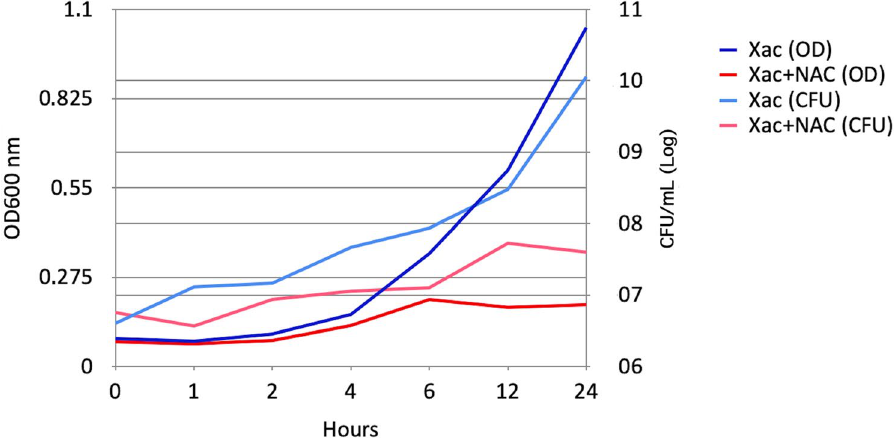
Figure 1. Growth curve profiles of Xanthomonas citri subsp. citri in presence of NAC. Six time points 1, 2, 4, 6 12 and 24 h were evaluated after 8 mg/mL of NAC addition as well as non-treated control through OD and CFU measures. After 6 h, a significant lower growth was observed for the bacteria treated with NAC ( P <